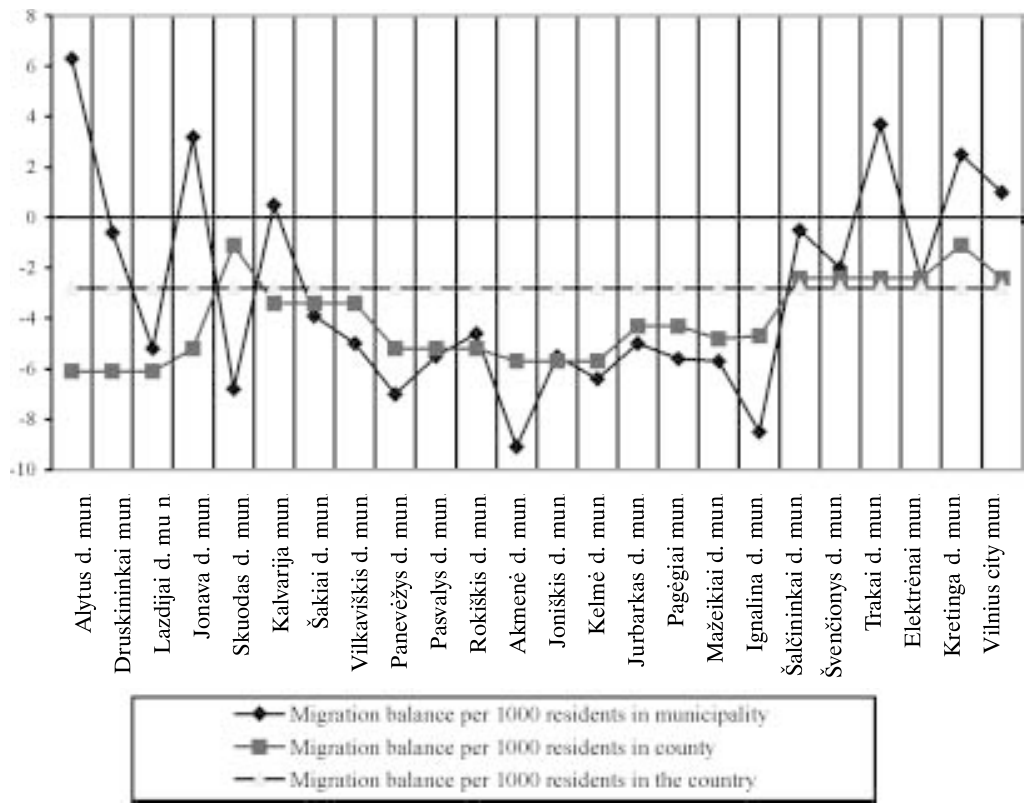
Fig 5. Migration balance in municipalities of the depressive regions of the country in